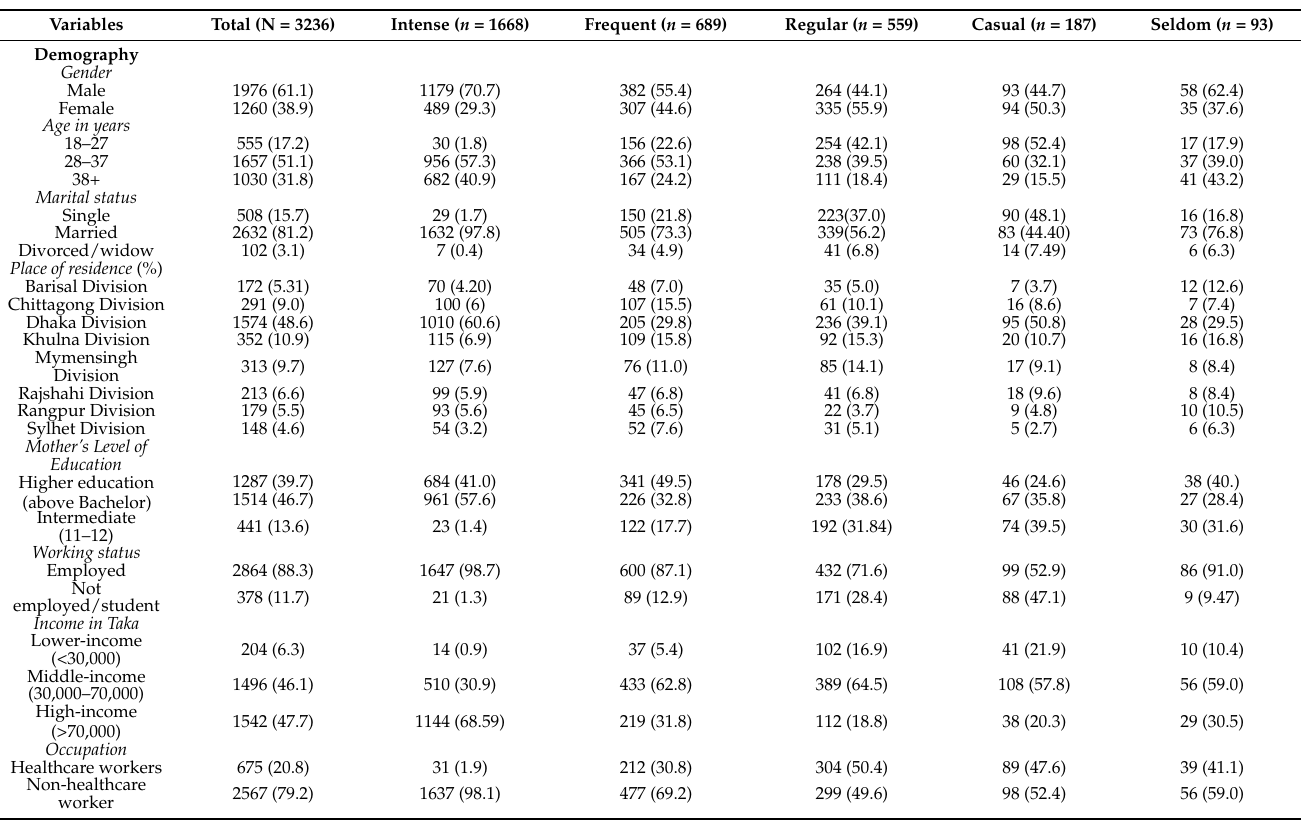
Table 1. Demographic characteristics according to the frequency of internet use among adults in Bangladesh. Values are expressed as numbers and percentages ( n ,